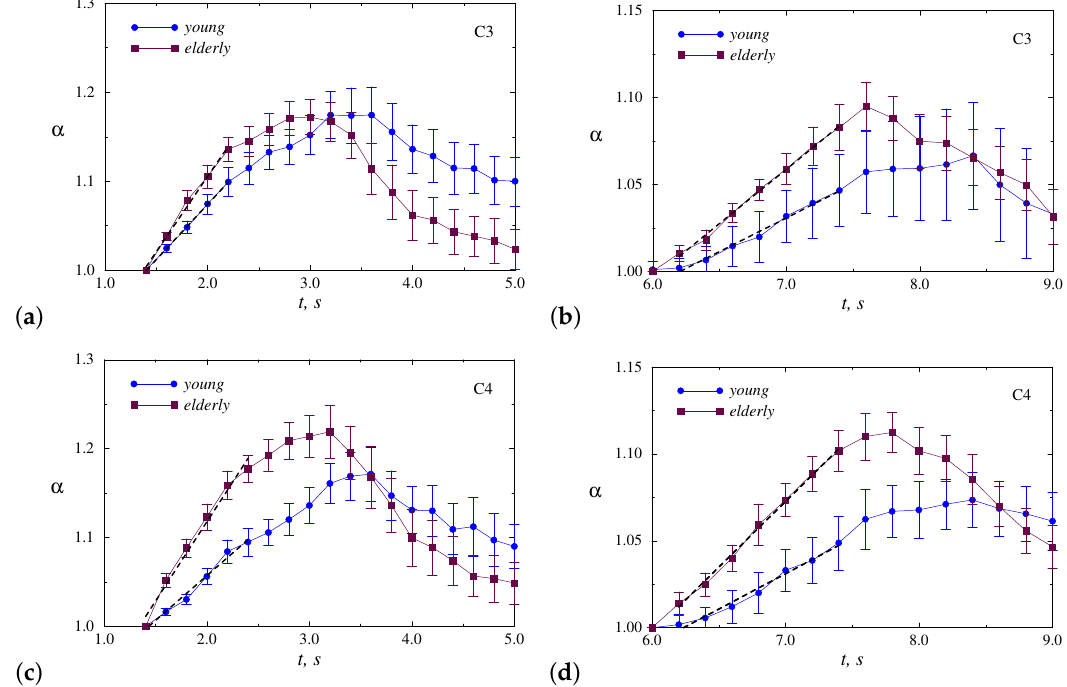
Figure 4. Normalized dependencies α ( t ) averaged over all motor tasks, which are presented for two segments: clenching ( a , c ) and unclenching ( b , d ) the hand. Slopes r of the dashed lines are used for inter-group separation. The results are shown for the channels C 3 ( a , b ) and C 4 ( c , d ).